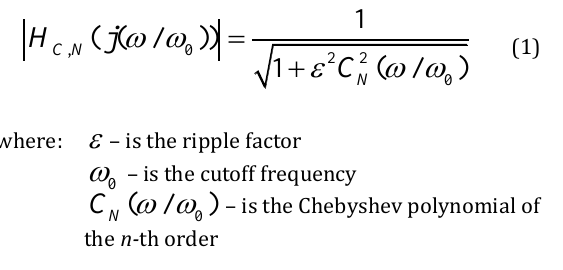
Fig 2. White matter hyperintensities in the frontal lobe (a.) and parietal area (b.) in SCH+WM patient. a.